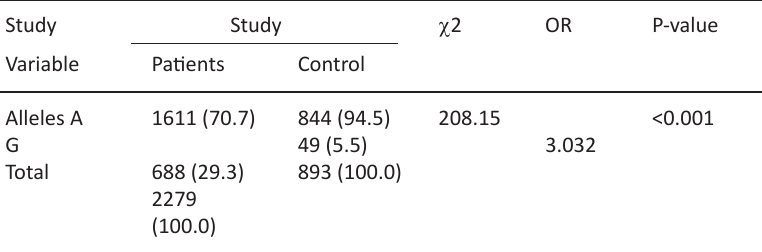
Table 4. Allelic frequencies of -54 G/A polymorphism in MBL in preterm labor Study Study χ 2